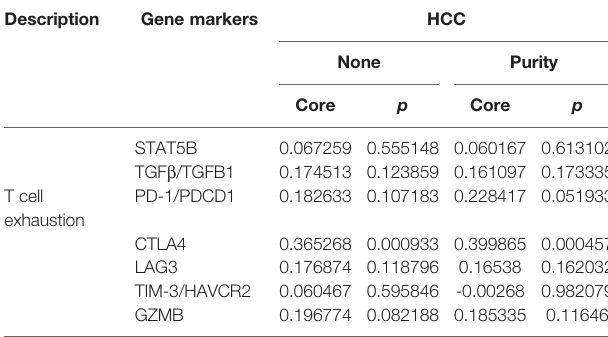
TABLE 3 | Correlation analysis between ATP1B3 and relate genes and markers of immune cells in